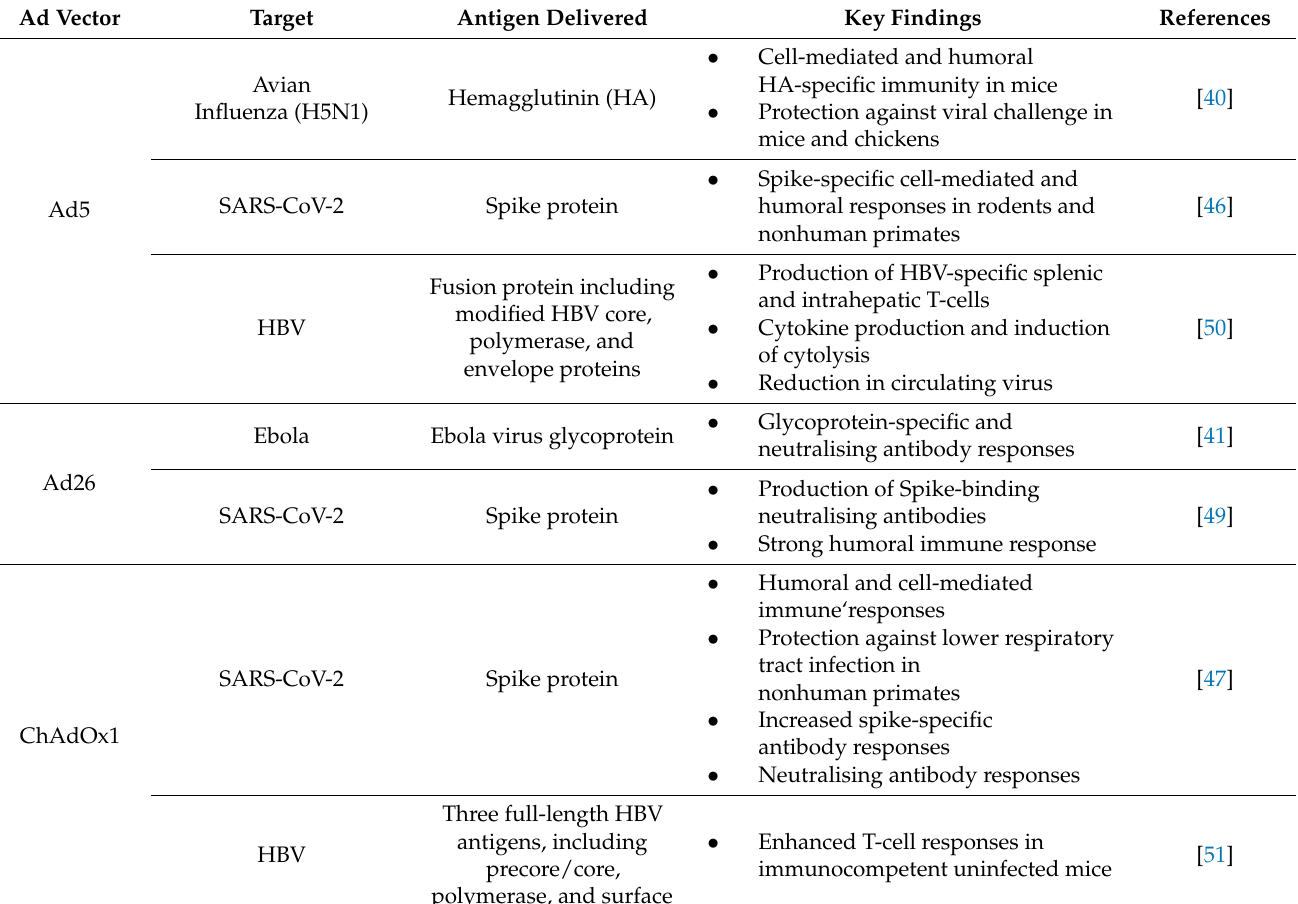
Table 1. Commonly used AdVs in anti-viral vaccine and immunotherapeutic